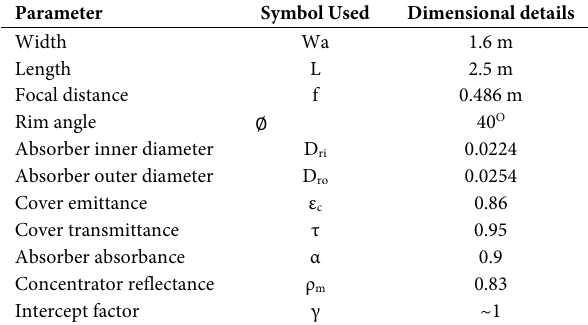
Table 3. Specifications of the PTC